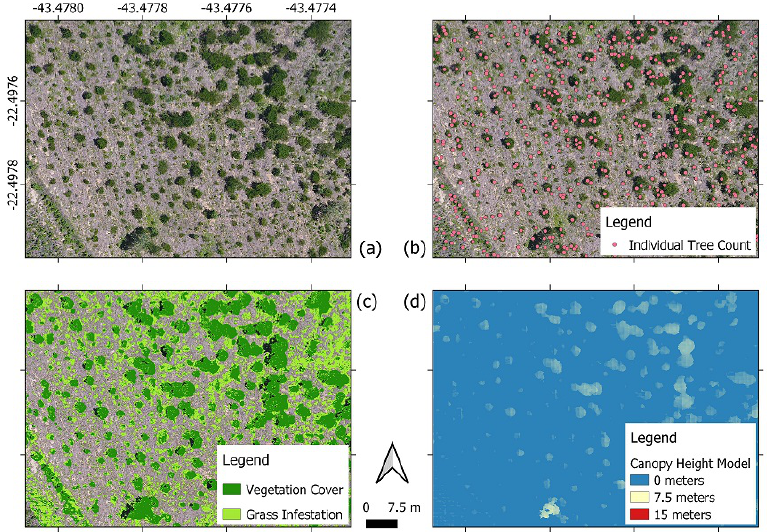
Figure 8. FR structural parameters results of the study area in a high mapping scale. ( a ) The RPA orthomosaic. ( b ) The Individual Tree Count, which provided the Tree Density result when dividing all the identified trees by the area. ( c ) The Vegetation Cover and Grass Infestation results. ( d ) The Canopy Height Model (CHM), which provided the height of the trees that were automatically identified and where zero CHM values means grasses or bare soil